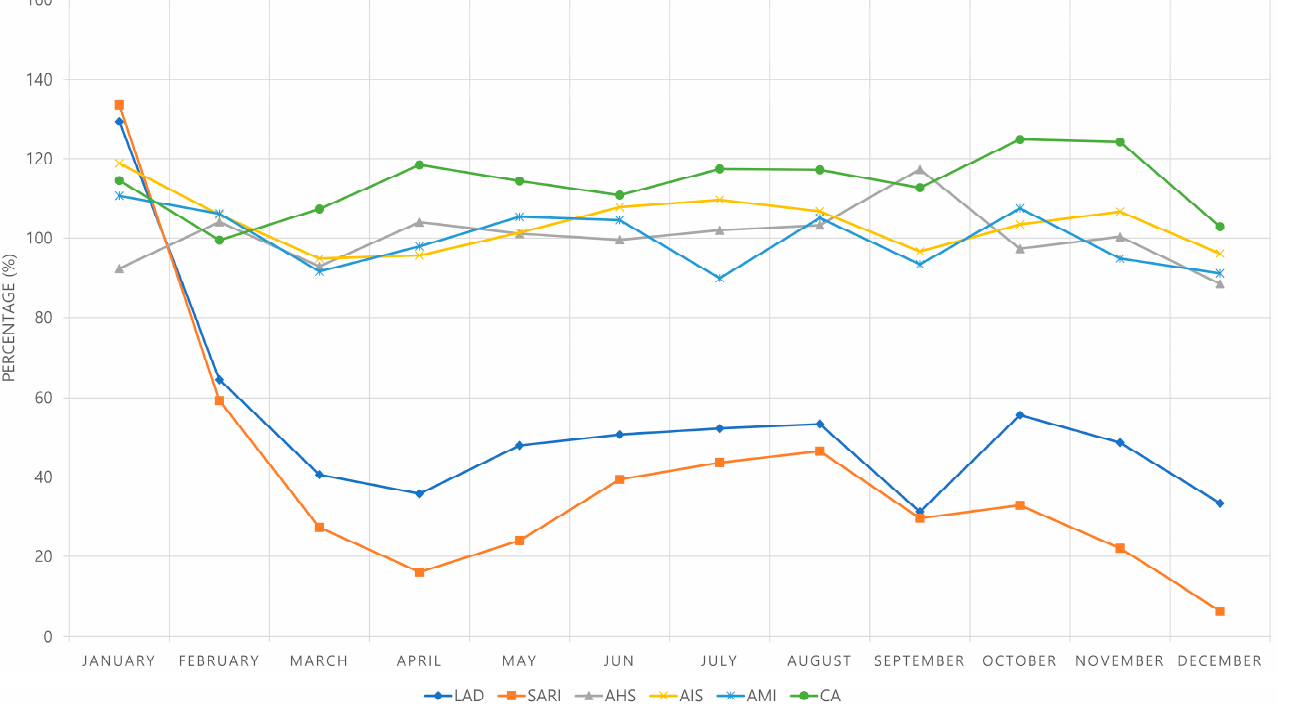
Figure 1. Monthly ED visit rate in 2020 compared to those in the control period. For the investigation of monthly trends from 2018 to 2020, monthly ED visit rates after ED visits for each month in 2020 were compared with the average numbers of the corresponding months in the control period. LAD = Low ‐ acuity disease, SARI = Severe acute respiratory infection, AHS = Acute hemorrhagic stroke, AIS = Acute ischemic stroke, AMI = Acute myocardial infarction, CA = Cardiac arrest, ED = emergency department.